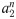
(a) Black line shows the boundary conformation at time t = 0 given by Eq (24). Blue arrows show the initial flow field, scaled for visibility. (b) Evolution of the shape factor a2n (see Eq (25)) with respect to the simulation time t (log scale) for values of the surface tension γ (in simulation units) spanning two orders of magnitude.